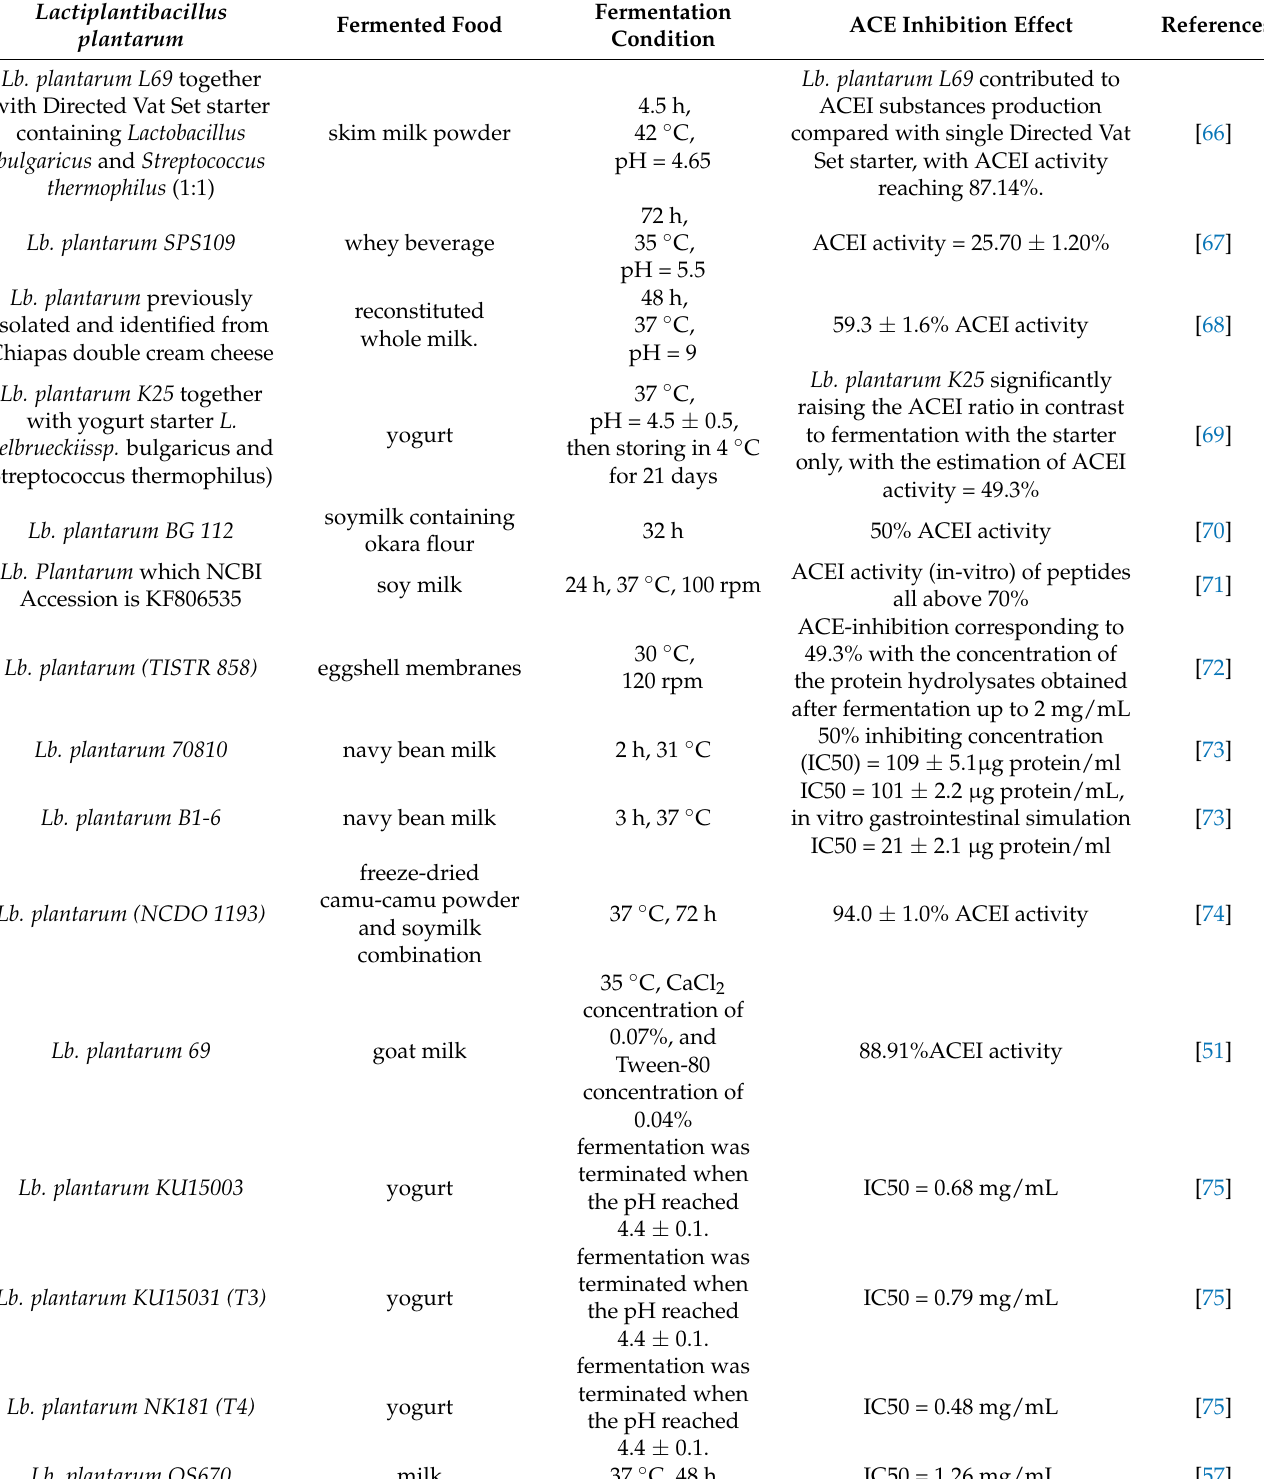
Table 2. The ACEI activity of different kinds of foods fermented by Lb. plantarum